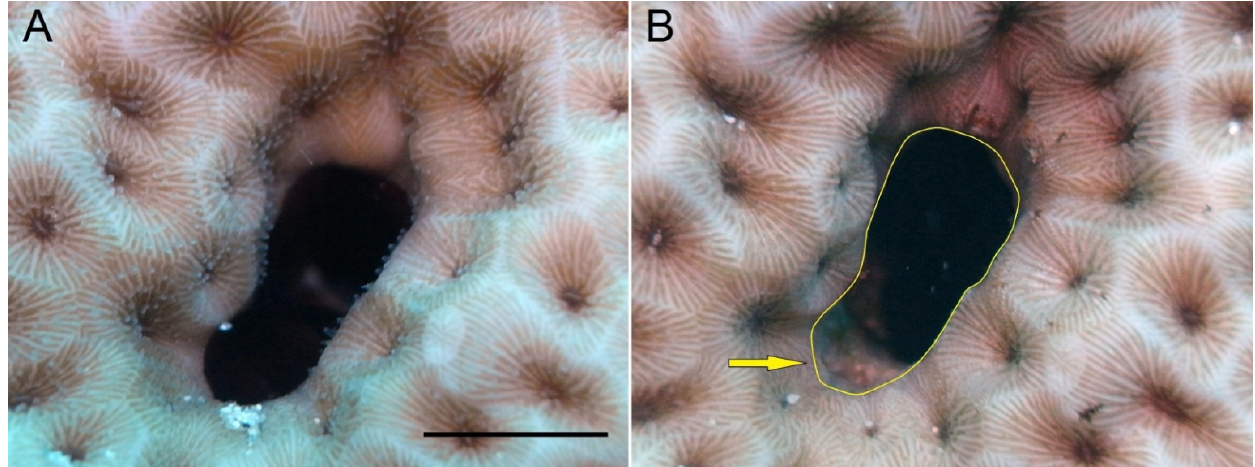
Figure 3. Leiosolenus boring in a colony of Siderastrea siderea in Curaçao with a funnel-shaped entrance. ( A ) The mussel’s black mantle tissue expanded with a keyhole-shaped outline. ( B ) The same borehole (from a slightly different angle) with part of the mantle tissue withdrawn (arrow and contour line showing the previous position as depicted in ( A )). Retraction of the mantle tissue reveals even more that the opening is funnel shaped. Scale bar: 0.5 cm.